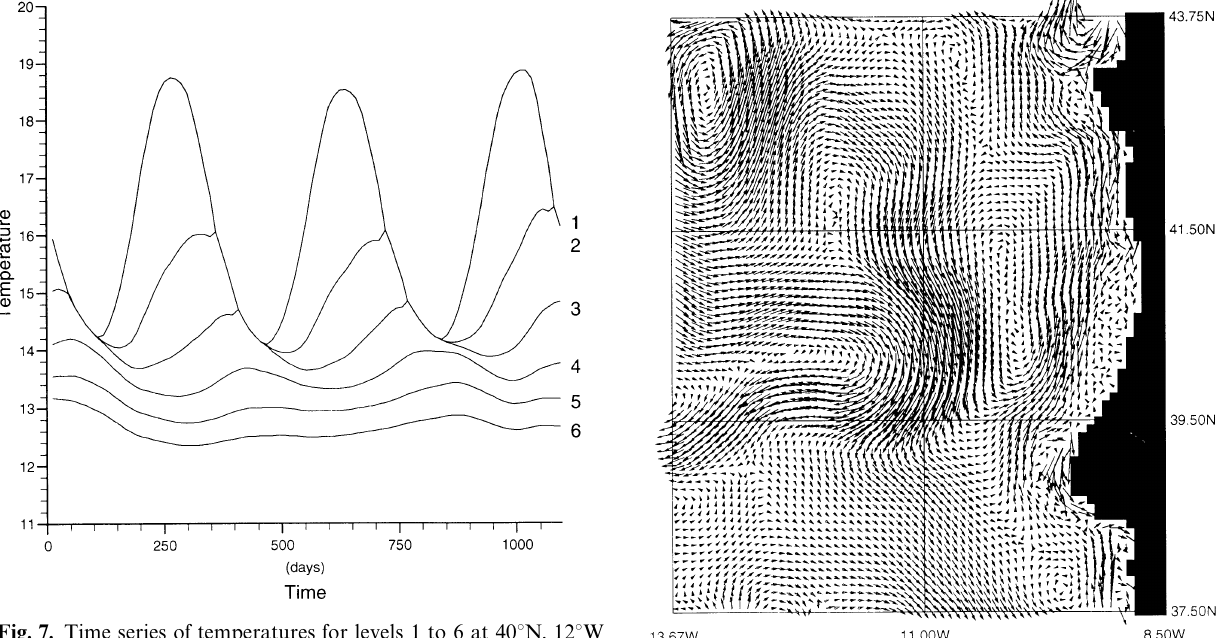
Fig. 7. Time series of temperatures for levels 1 to 6 at 40 ° N, 12 ° W for case C. ‚ evel (cid:49) (10.3 m), level (cid:50) (32 m), level (cid:51) (57 m), level (cid:52) (86 m), level (cid:53) (120 m) and level (cid:54) (162 m) Fig. 8. Winter velocity field at level 2 (32 m) for case D with ECMWF winds. Compare with Fig. 5a for case C with Hellerman and Rosenstein